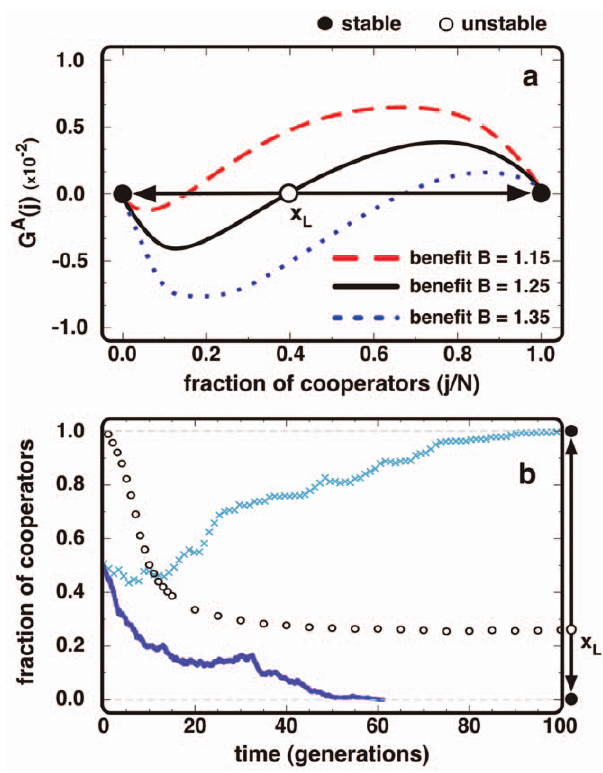
Figure 3. AGoS on BA networks. ( a ) Starting from a defection dominant PD played at an individual level, a coordination dynamics emerges at a global, population-wide scale, for the three values of B depicted. ( b ) Evolution of the unstable root x L of G A (j,t) (open circles), exhibiting the time-dependence of the global dynamics; solid (dark blue) line and (light blue) crosses show two independent evolutionary runs starting from 50% of C s and D s randomly placed. The ultimate fate of C s in each run depends on whether the population composition crosses over the time-dependent value x L of G A (j,t) thereby overcoming the dynamical coordination barrier during evolution. ( B =1.25 , N =10 3 , , k . =4 and b =0.1 ). BA networks were obtained combining growth and preferential attachment, following the model proposed by Baraba´si and Albert [61].